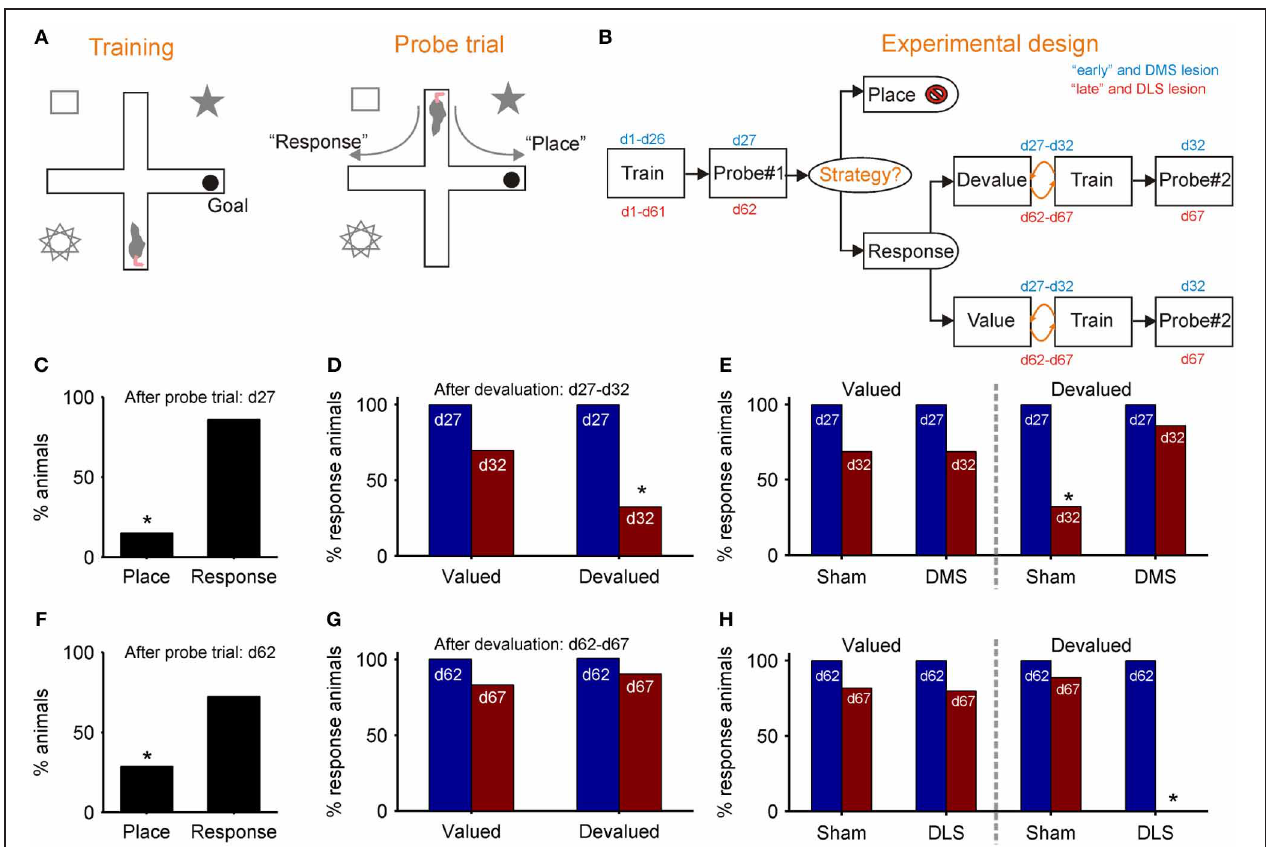
FIGURE 3 | Evidence for model-based and model-free navigation in data reported by De Leonibus et al. (2011). (A) Dual-solution plus-maze task used by De Leonibus et al. (2011). On training trials, rats always start from the same arm (south) and have to learn the location of the reward in a consistently baited arm (e.g., east). After training, a probe trial starting in the opposite arm is used to ascertain the rat’s strategy for locating the reward (a food pellet): a “response” strategy based on direction of turn, or a “place” strategy based on location of reward with respect to extra-maze cues. (B) The experimental design of De Leonibus et al. (2011). Rats were in two broad categories, designated “early” and “late” with respect to the first probe trial (day 27 or day 62). All “response” rats from that trial were taken forward to the second stage, and split approximately evenly into devaluation and control (value) groups. Both groups had free access to food pellet reward for 15 min immediately after training for each of five days; the devaluation group received an injection of LiCl immediately afterwards, the control group